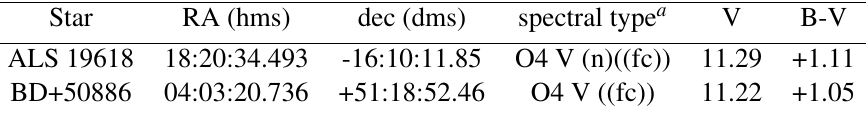
Table 1 Observational data of two new galagtic O4V stars from